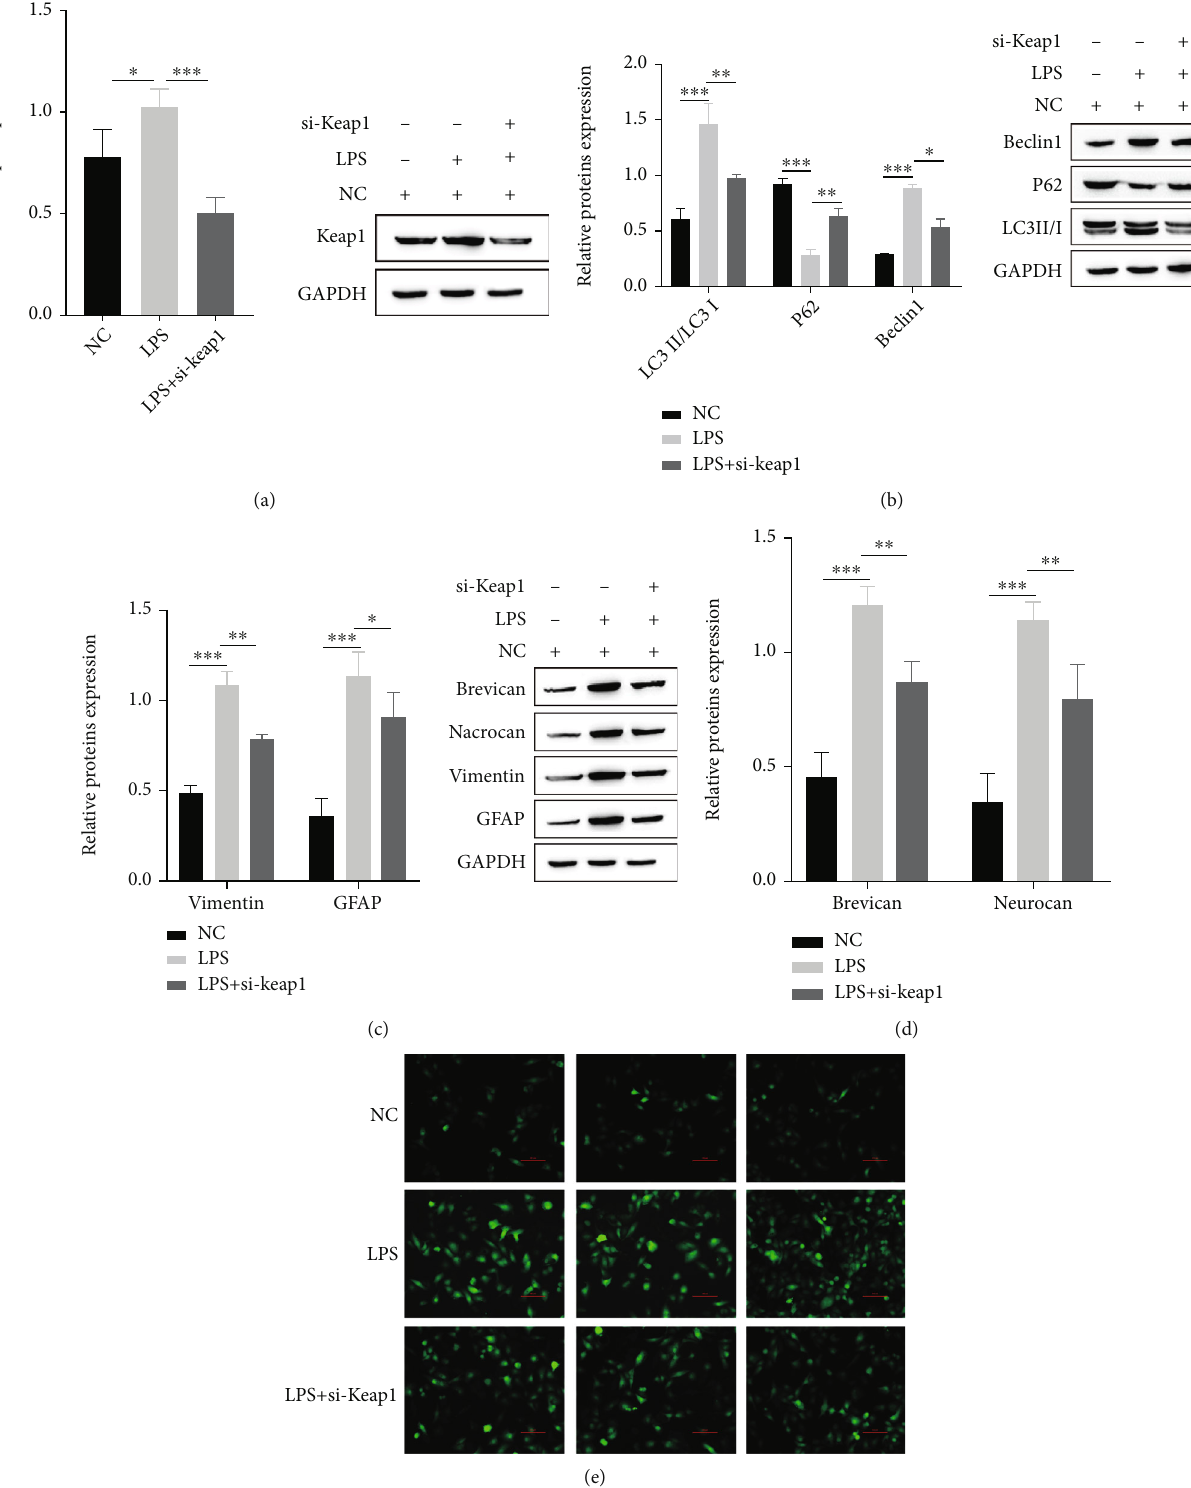
Figure 1: si-Keap1 alleviates LPS-induced oxidative damage induction and inhibits astrocyte autophagy. (a) Protein expression of Keap1 in astrocytes under LPS conditions under normal, LPS, and Keap1 knockdown conditions. (b) Expression of the associated autophagy proteins LC3II/I, P62, and Beclin1 in astrocytes under NC, LPS and LPS+Keap1 conditions. (c) Expression of the signature proteins GFAP and Vimentin of astrocytes under NC, LPS, and LPS+Keap1 conditions. (d) Expression of brevican and neurocan, a protein associated with glial scar formation, in NC, LPS, and LPS+Keap1 conditions. (e) DHE staining to detect the level of ROS in astrocytes under NC, LPS, and LPS+Keap1